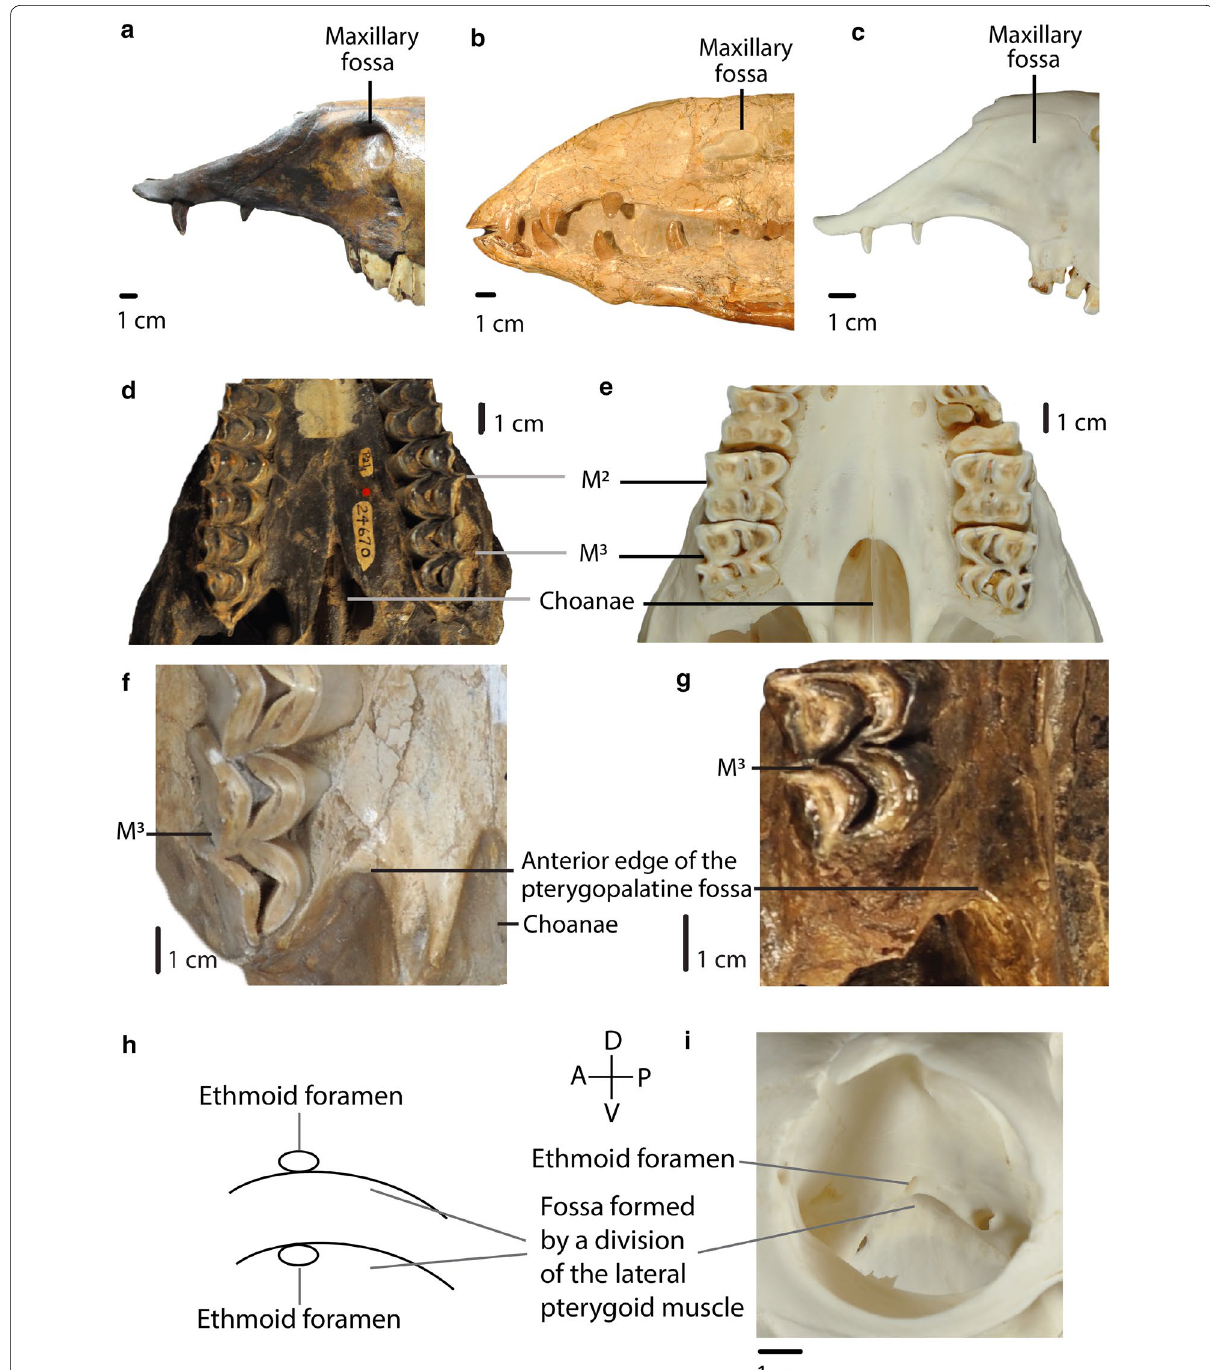
Fig. 7 A, B, C: Char. 26: “Maxillary fossa”. a C. hesternus (UCMP 20,040), left side, scored well‑developed, large pocket (0). b A. robustus (OMNH 016,560), right side, scored well‑developed, small pocket (1). c L. guanicoe (ZM 17,209), left side, scored shallow or absent (2). d , e : Char. 30: “Shape of the anterior edge of the choanae”. d P. vera (AMNH 24,670), ventral view, scored V‑shaped (0). e L. guanicoe (ZM 17,209), ventral view, scored U‑shaped (1). f , g : Char. 31: “Anterior edge of the pterygopalatine fossa”. f M. matthewi (UCMP 31,100), scored at the level of M3 (1). g T. longirostris (CM 2498), scored posterior to M3 (0). h , i : Char. 32: “Position of the ethmoid foramen”. h Upper: above the fossa formed by a division of the lateral pterygoid muscle (0). Lower: in the fossa formed by a division of the lateral pterygoid muscle (1). i L. guanicoe (ZM 17,209), right side, scored above the fossa formed by a division of the lateral pterygoid muscle